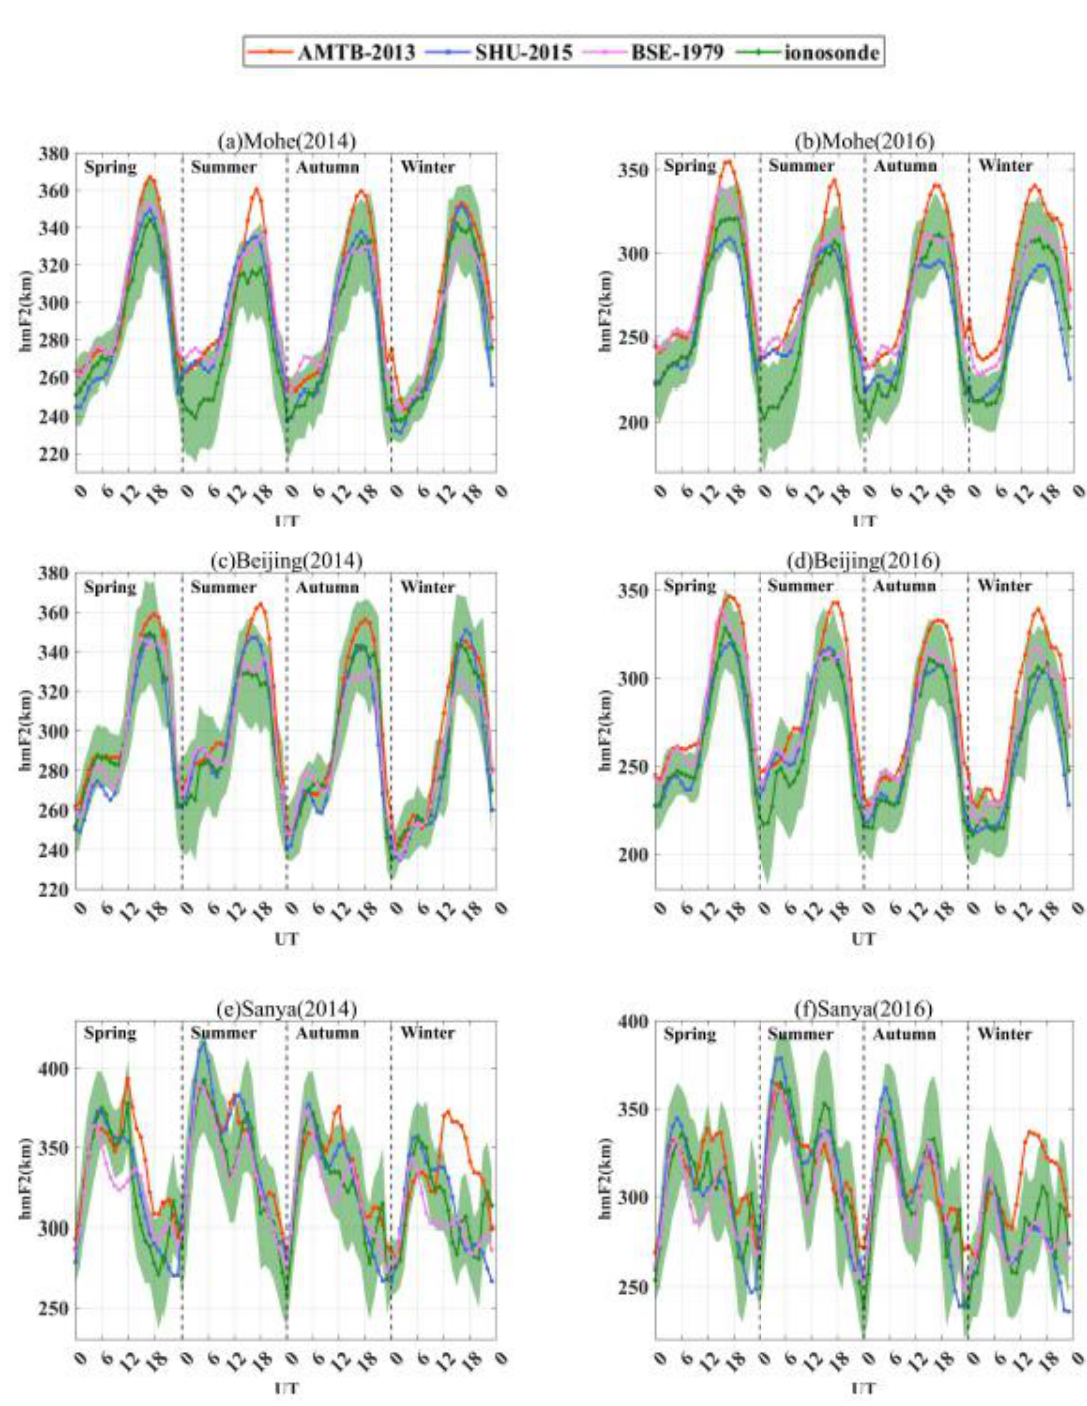
Figure 7. Diurnal variation of hmF2 from ionosonde and three IRI-2016 options in the four different seasons for the years 2014 and 2016 at Mohe, Beijing and Sanya over China. ( a ) Mohe(2014), ( b ) Mohe(2016), ( c ) Beijing(2014), ( d ) Beijing(2016), ( e ) Sanya(2014), ( f ) Sanya(2016).